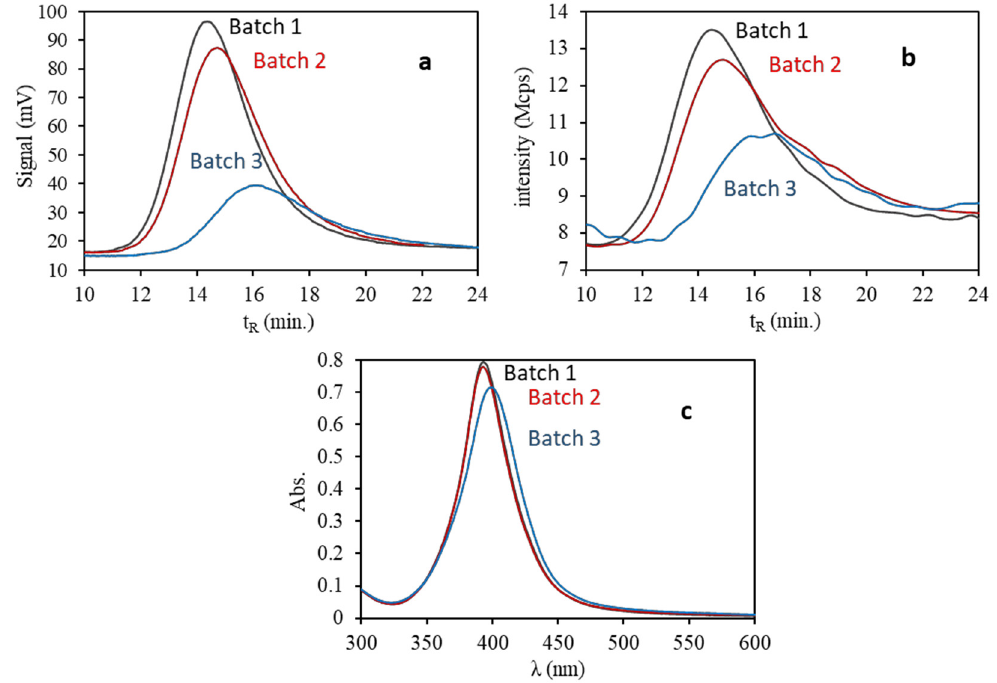
Figure 8. Fractograms of three different batches of AgNPs 20 nm diluted 1:4 with ultrapure water (5 µg/mL) with UV-vis detection ( a ) and DLS detection ( b ) and their spectra ( c ). Table 3. Wavelength values ( λ ) of the plasmon maximum, width of the peak at half the maximum, extinction coefficient ( ε max ) obtained by UV-Vis spectroscopy and hydrodynamic diameter (DH) by DLS for three different commercial batches of AgNPs.